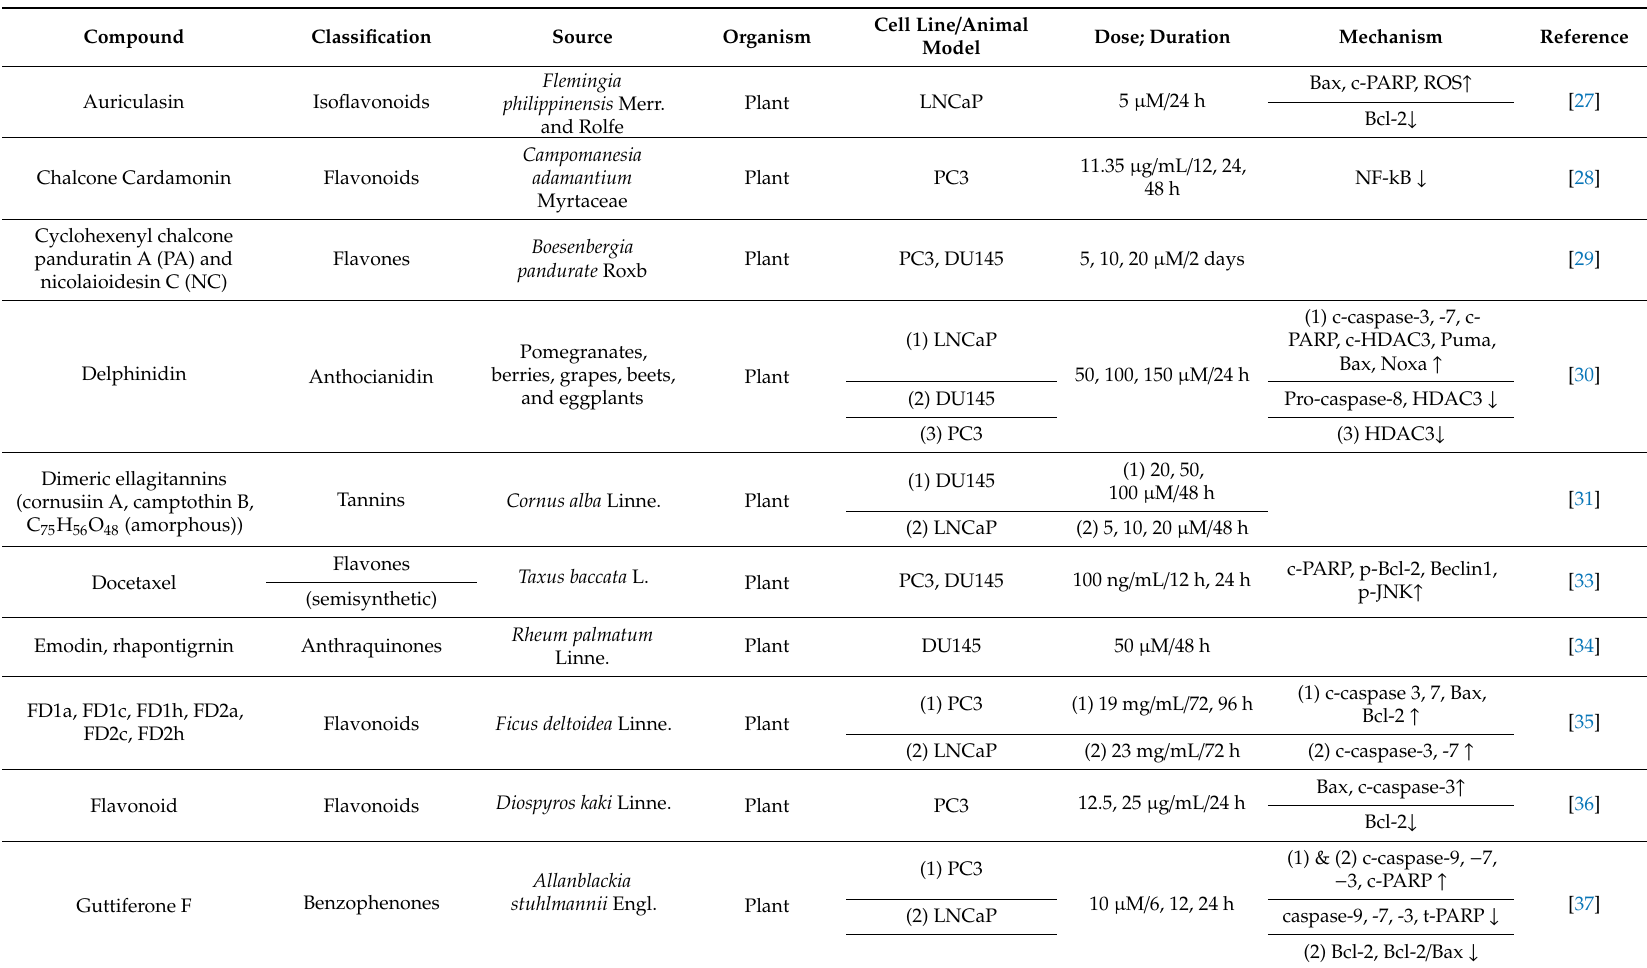
Table 1. Apoptosis inducing dietary compounds originated from